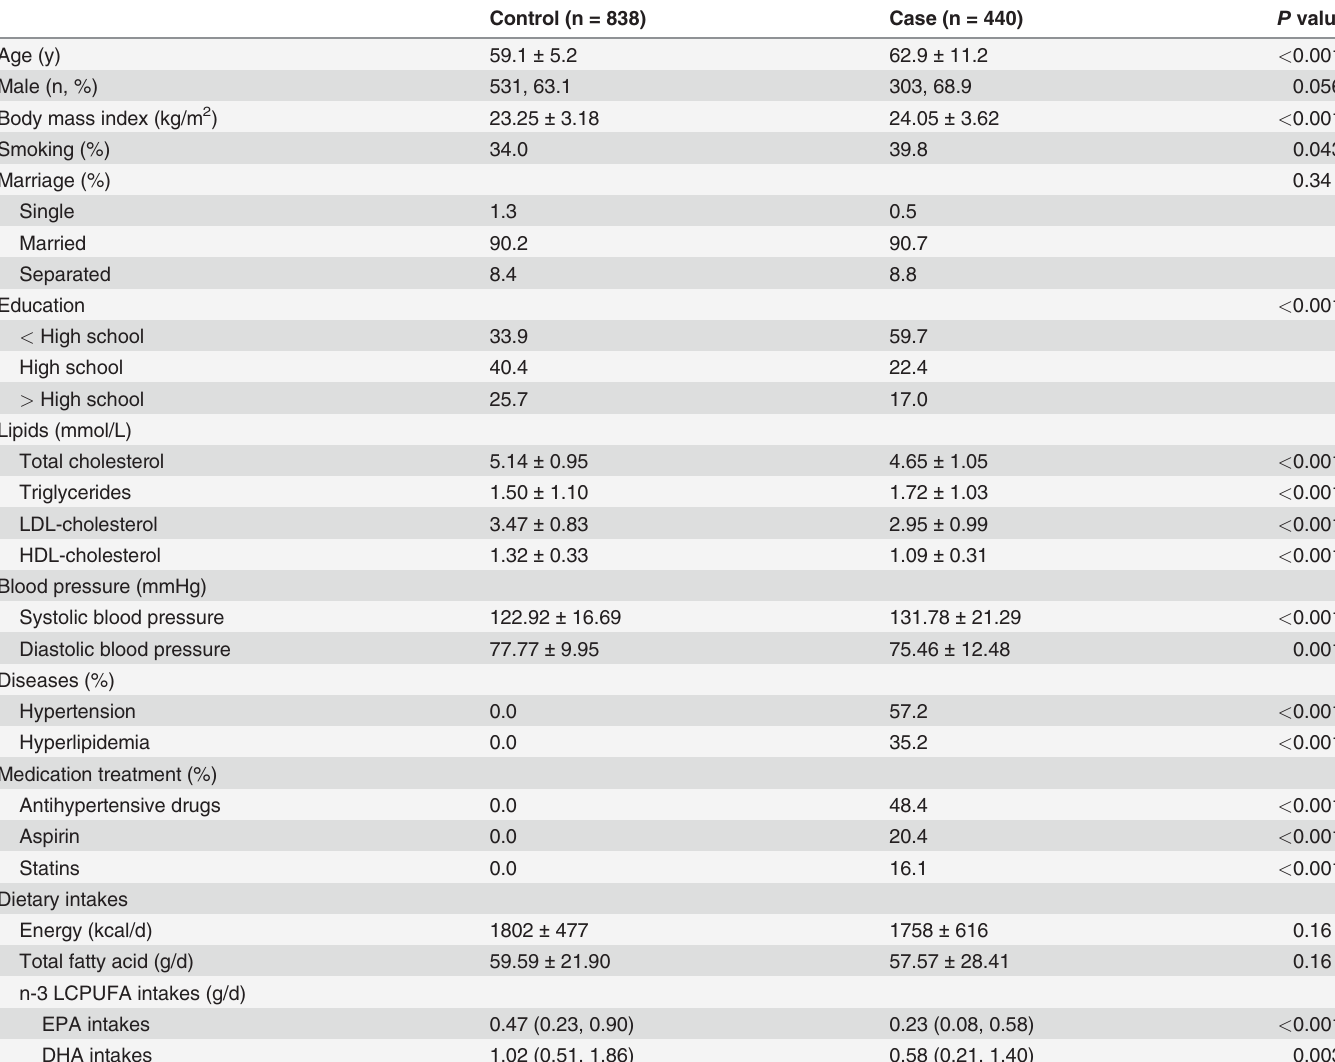
Table 1. General characteristics of the case-control study